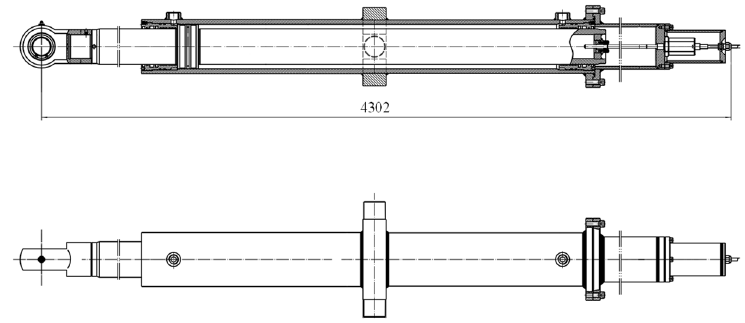
Figure 7. Structure of the vertical loading jack.